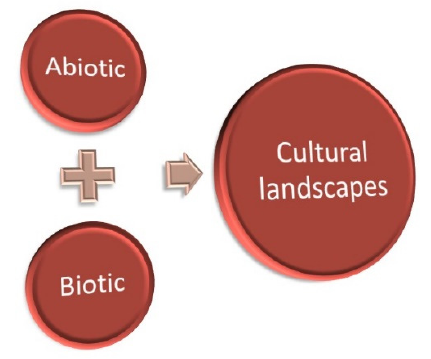
Figure 2. The ABC Approach of Dowling [35]. Consequently, the combination of the abiotic and biotic components of the environ- ment determines the cultural landscape and how people lived in the area in the past, as well as how they live there